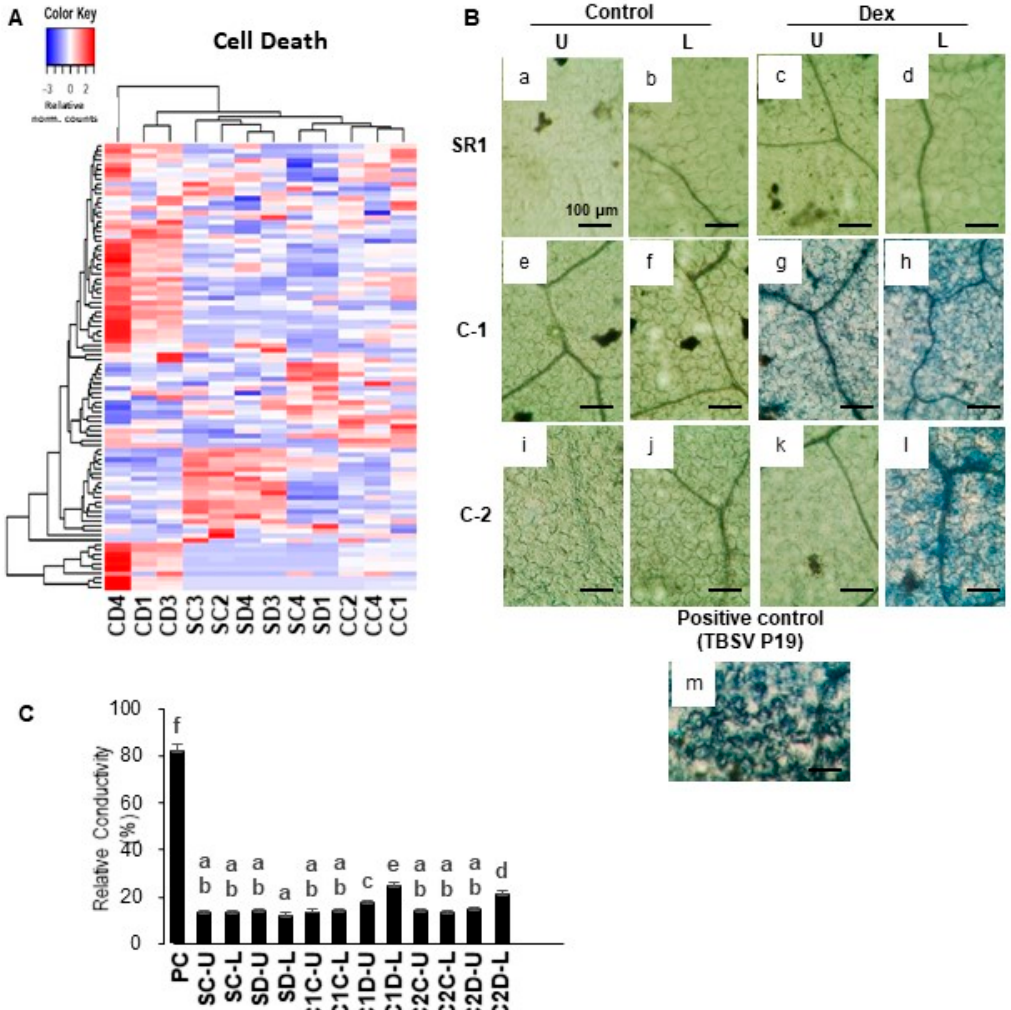
Figure 3. Hierarchical clustering of cell death-related genes and detection of cell death in i-amiCHLI plants. ( A ) The genes annotated with the GO term cell death (GO:0008219) were selected, and their relative-normalized count data were used to draw a heatmap. Each column represents a sample, and each row represents a gene selected. Differences in the expression are shown in different colors; red and blue represent the up- and down-regulated expression, respectively. ( B ) Control plants (SR1; a–d), i-amiCHLI transgenic line 1 (C-1; e–h), and line 2 (C-2; i–l) plants were grown, treated with control or Dex solution. They were harvested at 7 dpt followed by cell death assays. SR1 leaves transiently expressing TBSV P19 for 2 days served as a positive control (m). Cell death assay was performed in upper leaves (pointed by U) and lower leaves (pointed by L). Leaf disks of 6 mm in diameter were stained with Trypan blue and photographed at microscopic levels (a–m; scale bars denote 100 µ m). ( C ) Quantification of cell death by an electrolyte leakage assay. PC, positive control with transient TBSV P19 expression; SC, control-treated SR1; SD, Dex-treated SR1; C1C, control-treated line 1; C1D, Dex-treated line 1; C2C, control-treated line 2; C2D, Dex-treated line 2; U, upper leaves; L, lower leaves. Error bars denote standard deviations in triplicate experiments. Different letters indicate a statistically significant difference between treatments (LSD test, p < 0.05). The experiment was repeated at least three times.